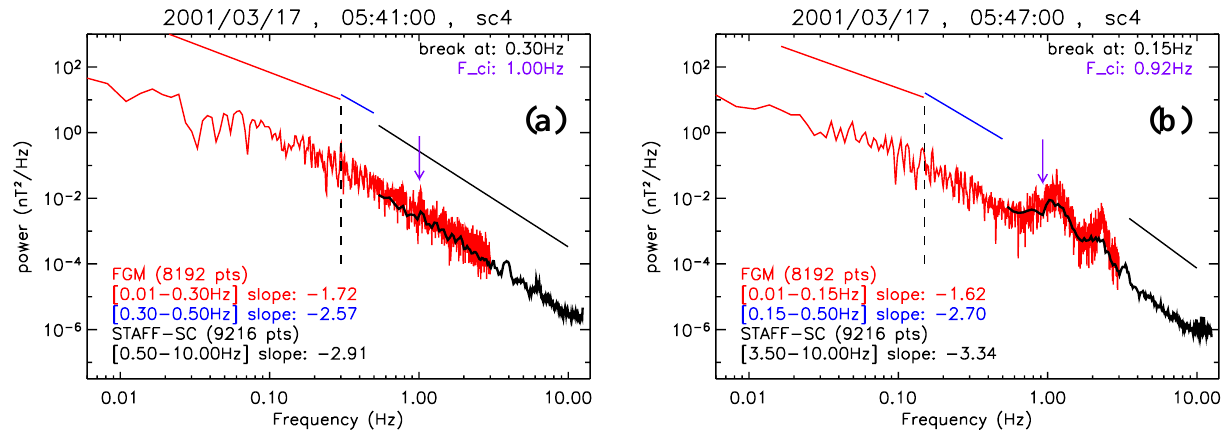
Fig. 14. Power spectra measured by sc4 at 05:41 UT (a) and at 05:47 UT (b) and their spectral slopes at inertial and dissipation range.